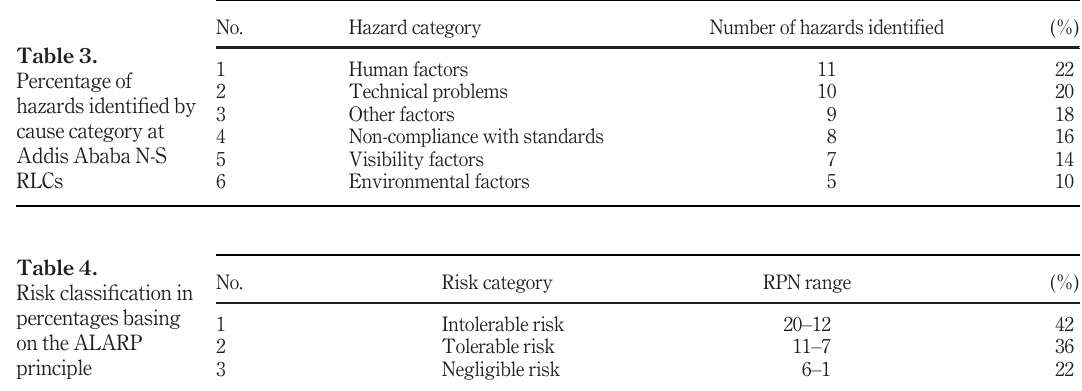
Table 3. Percentage of hazards identi fi ed by